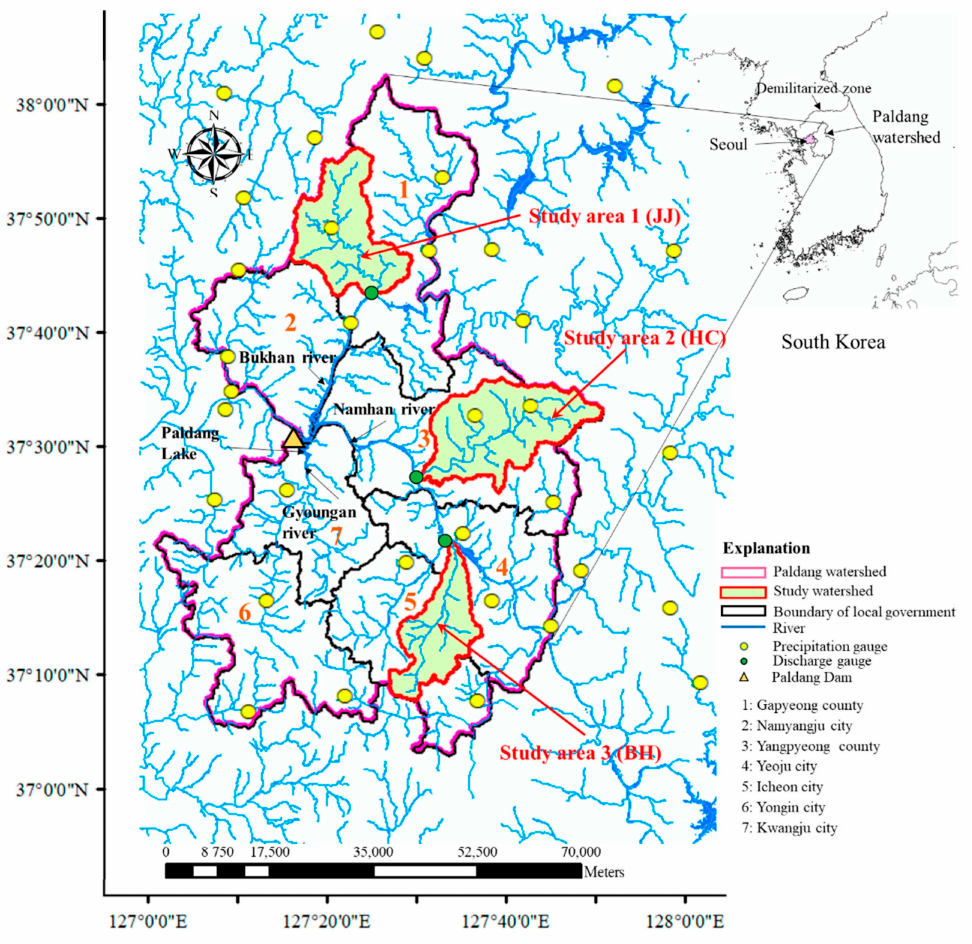
Figure 1. Location map of the study area.